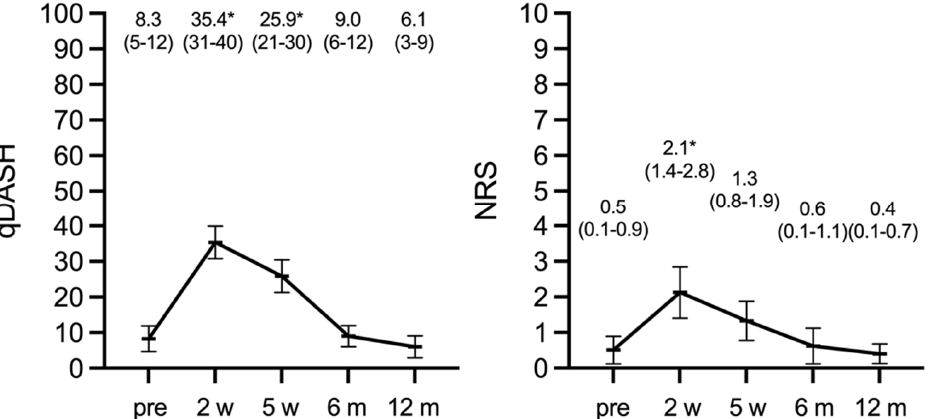
Figure 2. qDASH and NRS pain score, preinjury (pre), two weeks (w), five weeks (w), six and 12 months (m); * p < 0.05 compared with preoperative, i.e., recalled